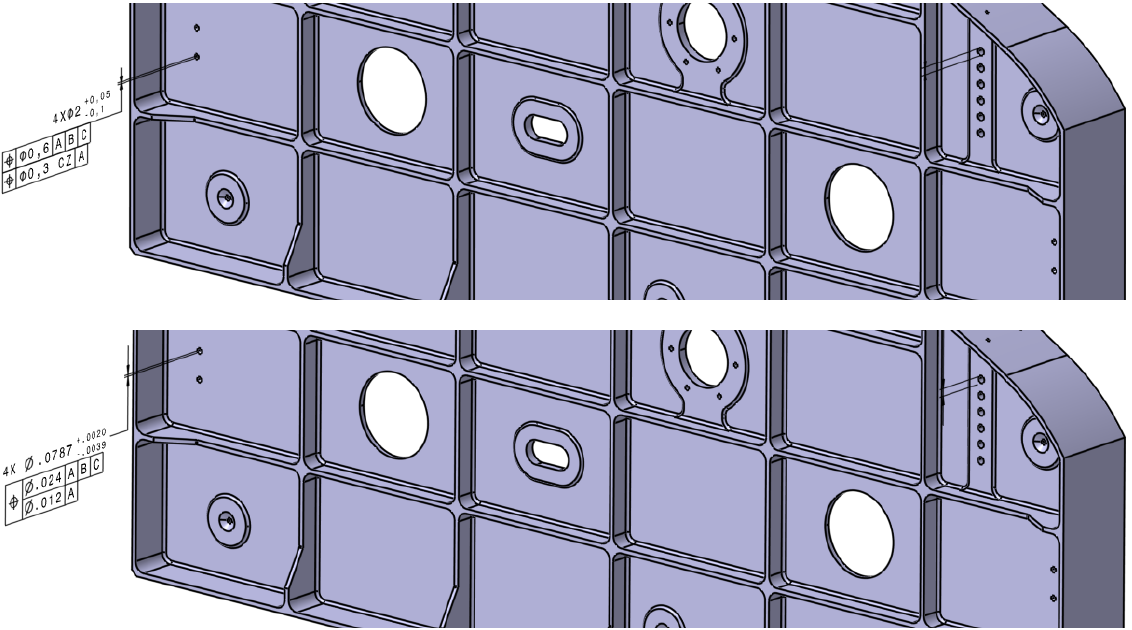
Figure A8. Wide hole pattern in ISO model ( top illustration) and Wide hole pattern in ASME model ( bottom illustration).